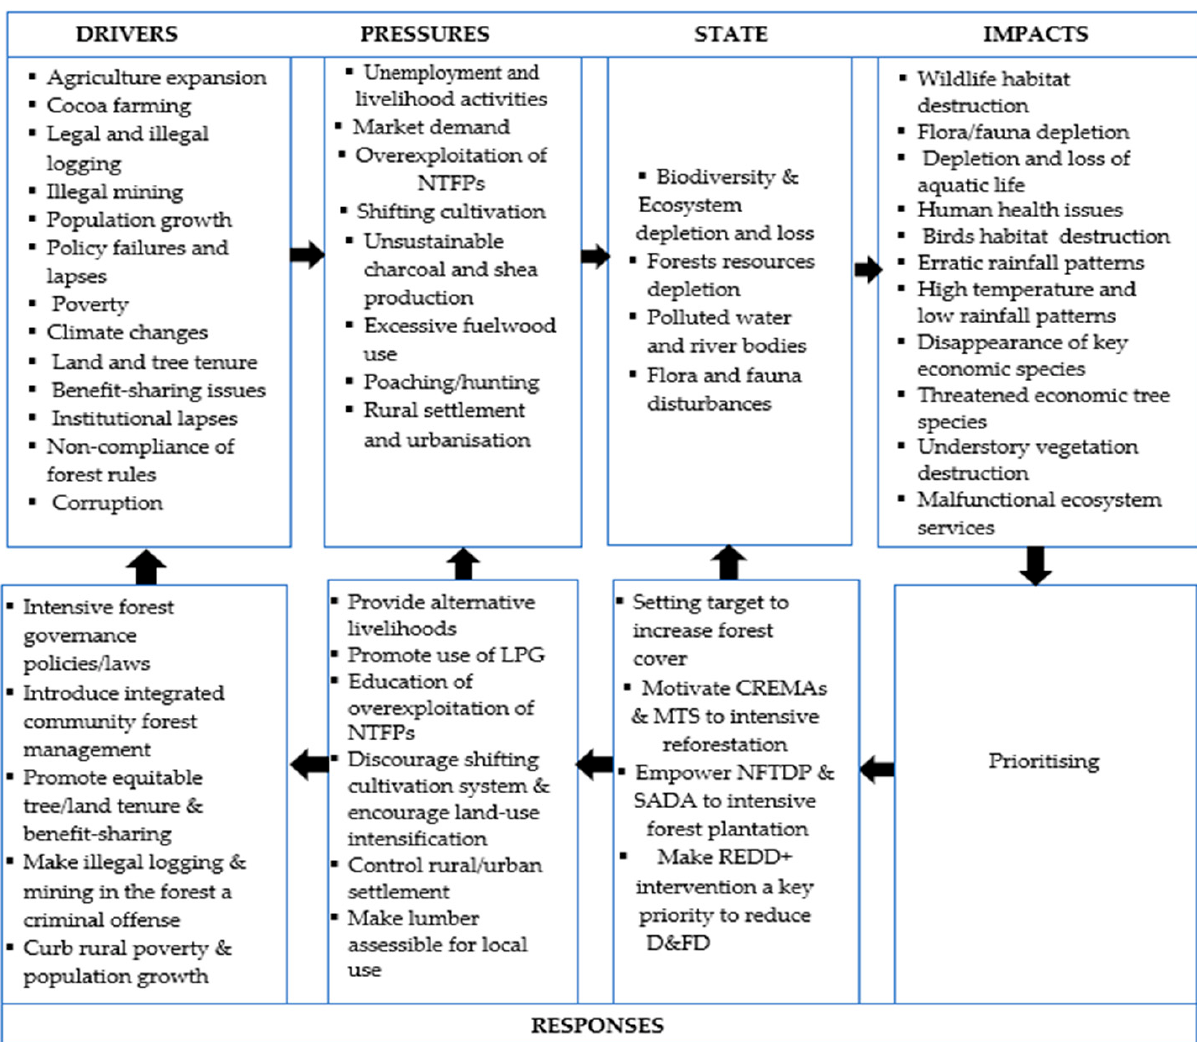
Figure 4. DPSIR Analytical framework on the causes of deforestation and forest degradation (D&FD) in Ghana.